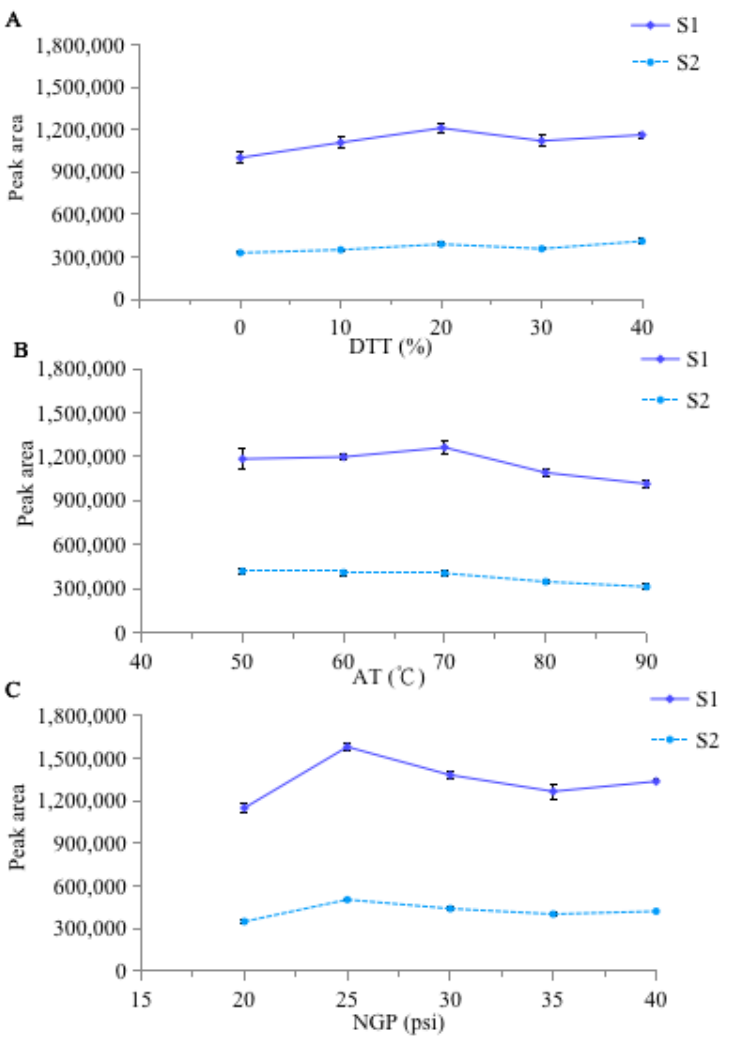
Figure 1. Effects of DTT( A ), AT( B ), and NGP ( C ) on ELSD signal response.